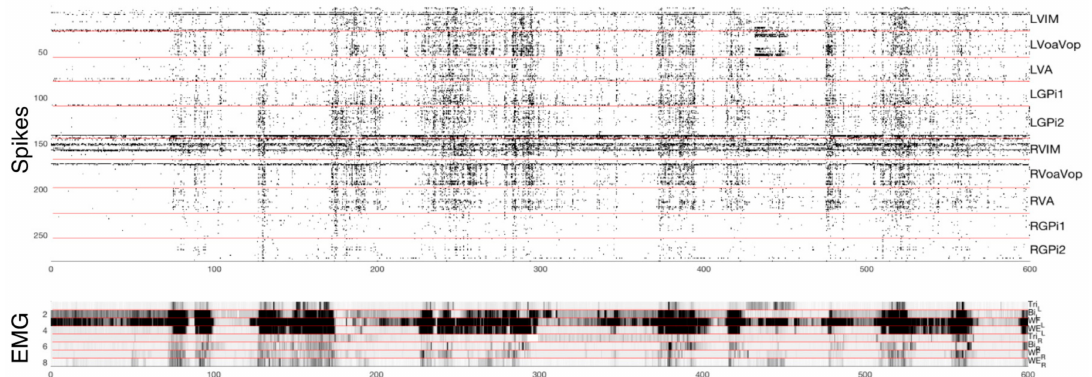
Figure 2. Top: microelectrode recordings with identified spikes from 250 distinct cells. Intracerebral recording locations are identified on the right. Bottom: Muscle activity (electromyograph, EMG) for 8 muscles with higher level of EMG plotted as dark. From top to bottom, muscles are Left triceps, biceps, wrist flexor group, wrist extensor group, right triceps, biceps, wrist flexor group, wrist extensor group. Horizontal axis is in seconds, and a total of 10 min are shown. Data are from patient NMU8 during attempted left arm